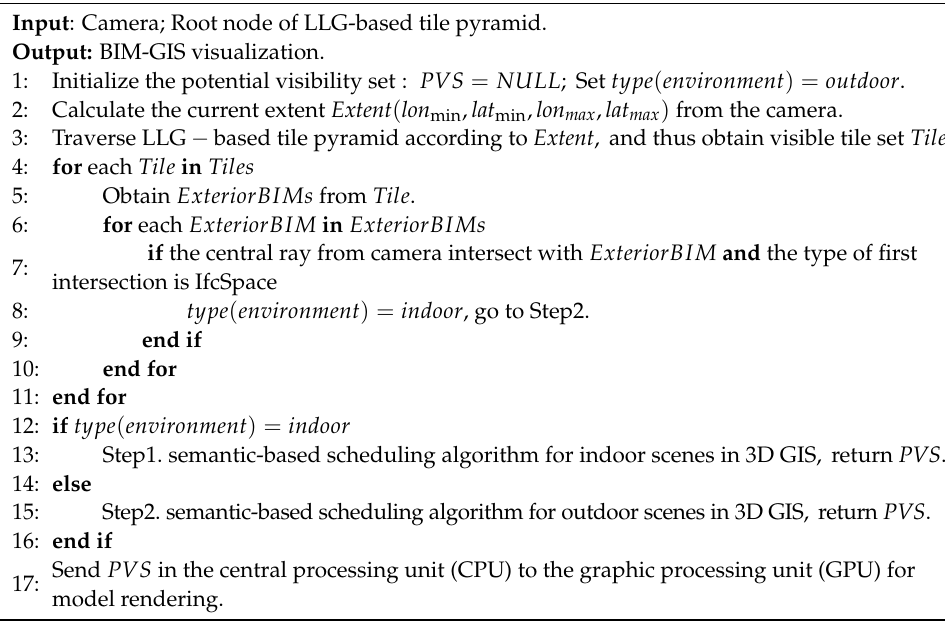
Algorithm 1. Semantic-based scheduling algorithm for indoor scenes in 3D